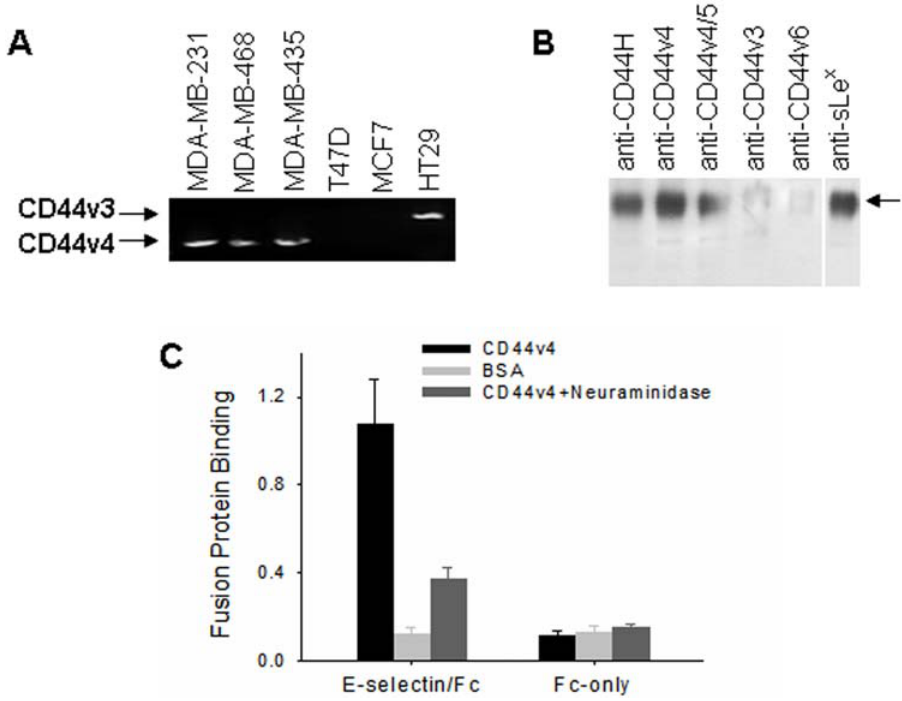
Figure 5. Identification of the CD44 variant isoform in metastatic breast cancer cells as CD44v4. A: RT-PCR amplification and DNA sequence of CD44 extracellular domain from various breast cancer cells and colonic HT29 cells. B: Western blot analysis of the 170 kD purified protein with antibodies specific to sLe x moieties and different CD44 variant isoforms, respectively. C: Specific binding of the 170 kD purified protein (CD44v4) to E-selectin through sLe x moieties. The data are represented as the mean 6 SD of three different